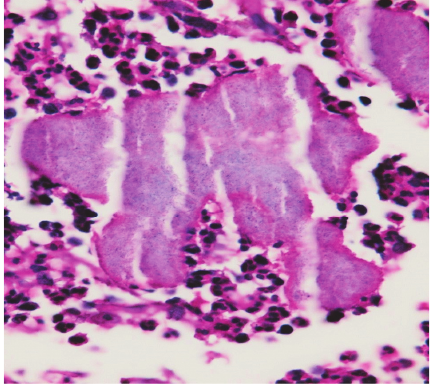
Figure 1: Swollen areas at the dorsum of the left hand and tender immobile nodules on the surgical scar.